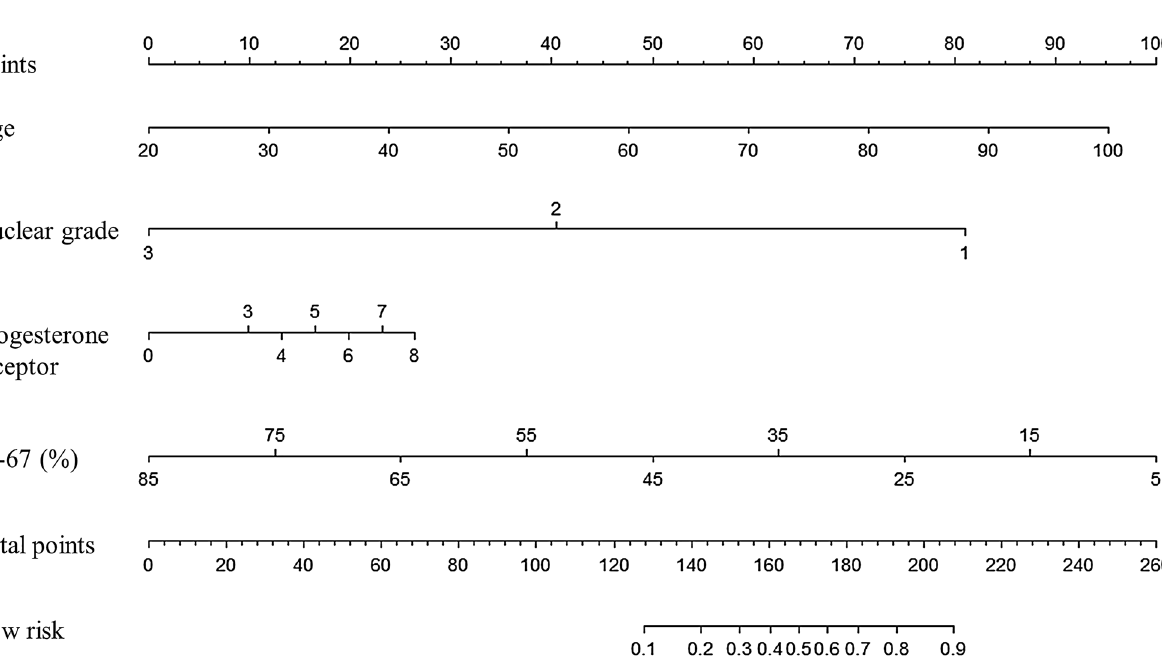
Figure 1. Nomogram to predict a MammaPrint low risk. Age, Progesterone receptor, nuclear grade, and Ki-67 levels were finally selected to develop the